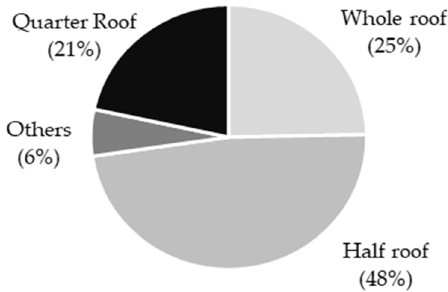
Figure 5. The portion of the roof used as a catchment for rainwater collection. The values in the parenthesis indicate the proportion of households.